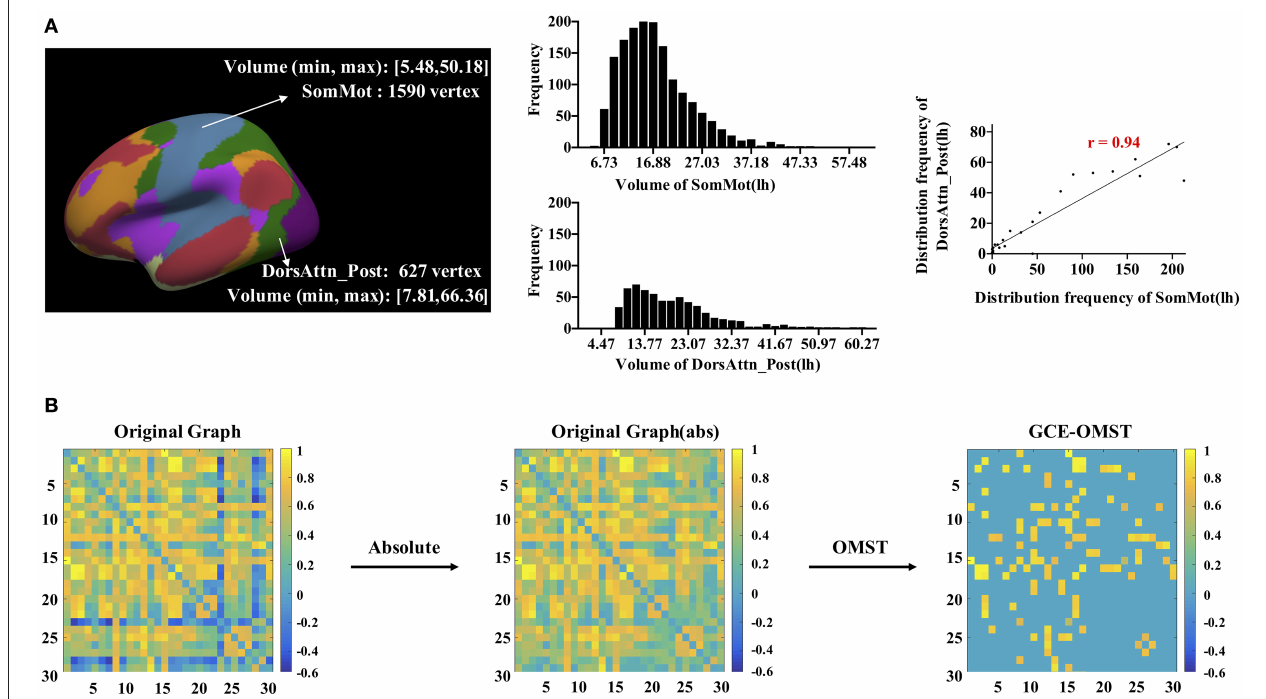
FIGURE 1 | The workflow for the construction and thresholding of the morphological network for cortical volume. (A) For each pair of parcels, like the left SomMot and the left DorsAttn_Post, we uniformly divided their volumes into 30 bins (5.4–66.4). Each bin had a width of (66.4–5.4)/30 = 2.03, and the frequency distribution histograms were presented in the middle. By computing the Pearson’s correlation of two sets of frequencies, we got the similarity of these two parcels. (B) showed the thresholding schemes of the network, and we first got absolute value of each connection in the network and then applied the data-driven thresholding scheme based on orthogonal minimal spanning trees